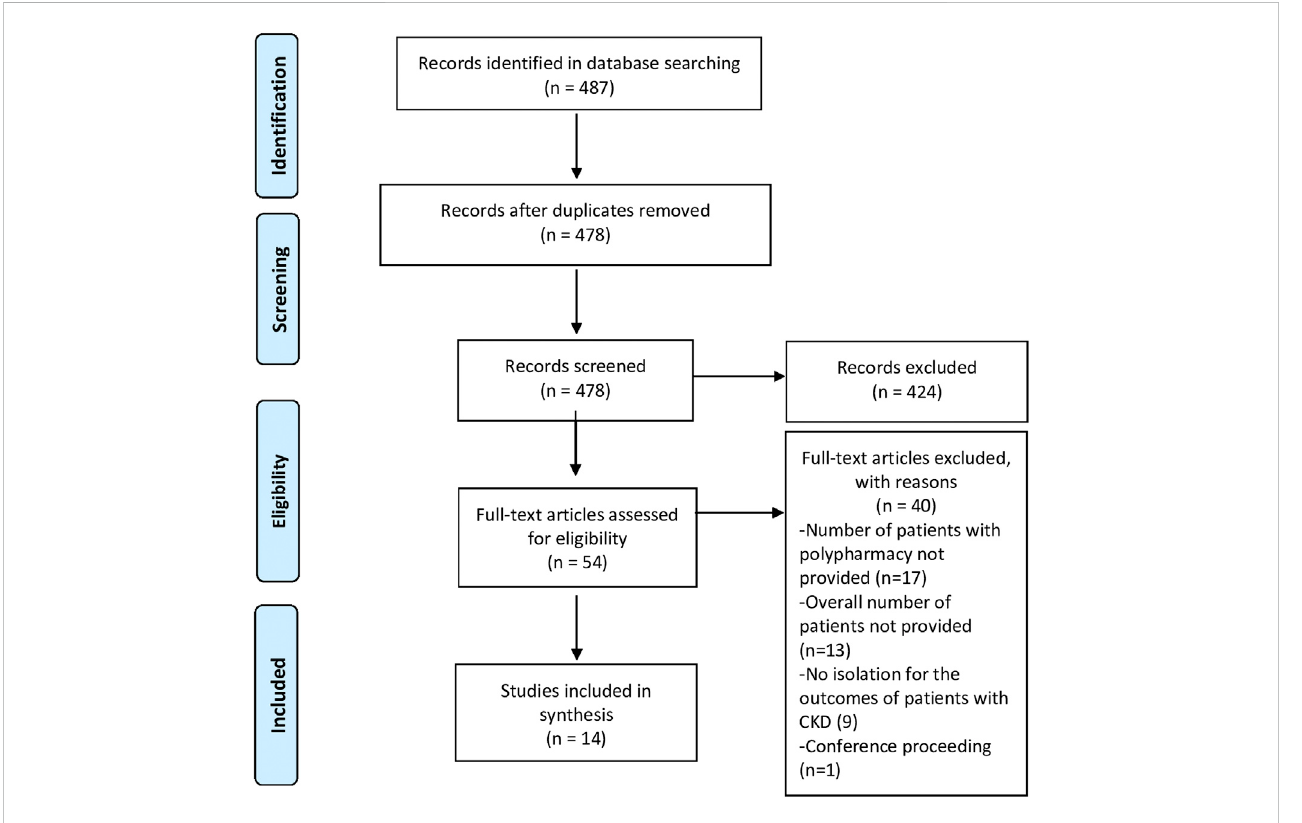
FIGURE 1 PRISMA fl ow diagram of the study selection